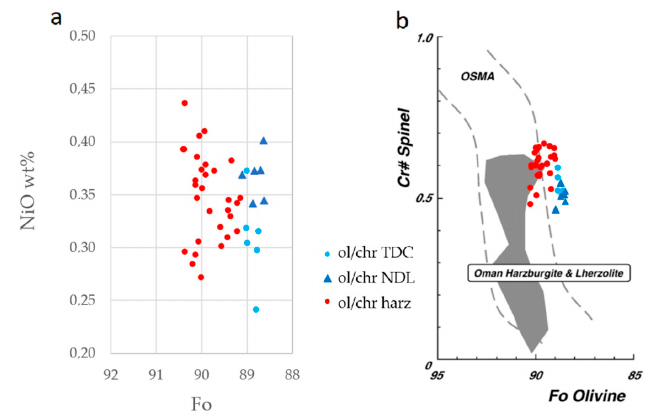
Figure 8. Binary diagrams: ( a ) NiO wt. % vs Fo; ( b ) Cr# vs. Fo, compositional relationship between Fo content of olivine and Cr# of spinel in the harzburgite (red circle), TDC (light blue) and NDL (dark blue), in the Wadi Tayin massif, from Holes BA1B and BA3A Holes (this study). OSMA (olivine-spinel mantle array; [42,43]) is a spinel peridotite restite trend. Range of Oman harzburgite and lherzolite are from Kadoshima [44] and Takazawa et al. [17]. Light and dark blue circles for dunite, red for harzburgite.